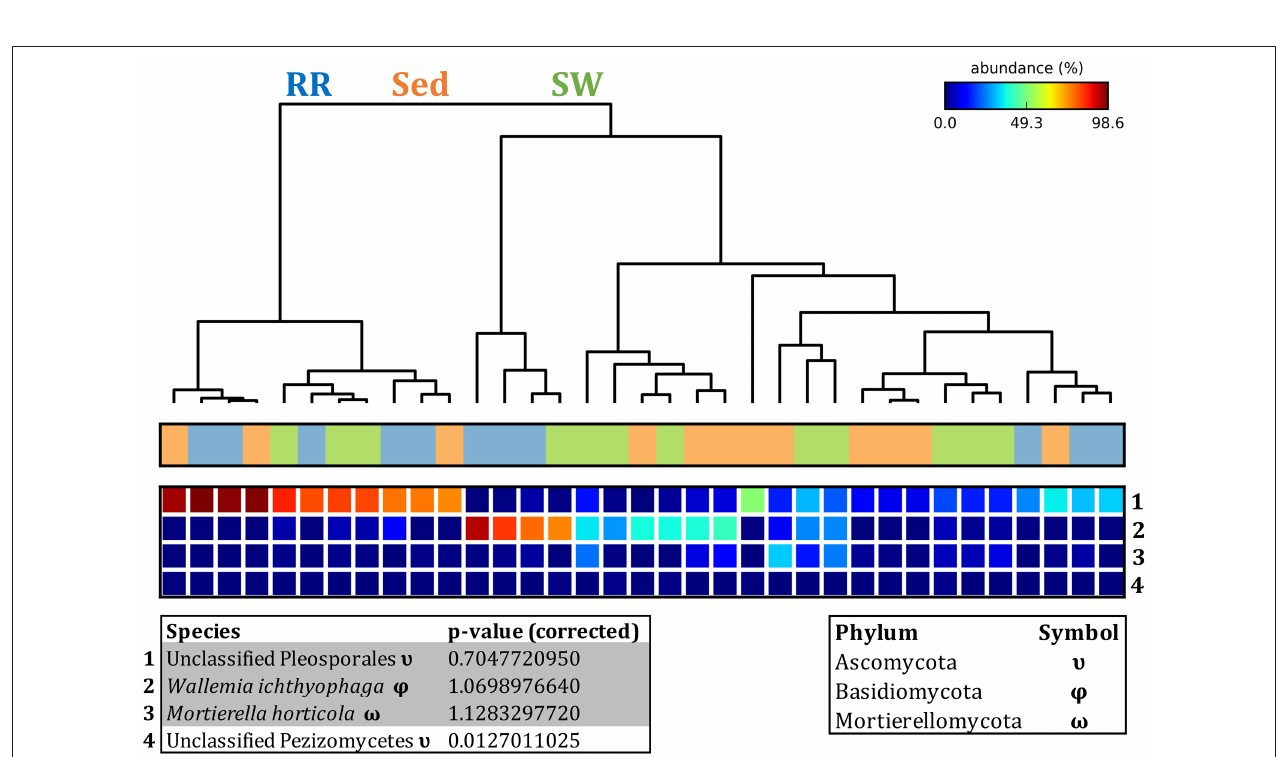
FIGURE 12 | Fungal discriminatory OTUs at the microenvironmental scale. Extensive hypothesis testing of taxonomic profiles was coupled with similarity percentages analyses (SIMPER) for fungal microbiomes across microenvironments. The proportion of sequences (mean frequency %) of OTUs significantly over-represented (Kruskal–Wallis H-test, α = 0.05, effect sizes: η 2 ) and consistently contributing to the differences between microenvironments is indicated by varying color intensities. Corrected p -values were calculated using the Benjamini–Hochberg’s approach. Two-way crossed SIMPER analyses were performed with site and microenvironment variables as factors (S17 Bray–Curtis similarity matrix). High contributors were selected from the top-5 contributors of each pair-wise comparison between microenvironments, and those OTUs consistently accounting for the dissimilarities between any given microenvironment and the other two microenvironments were chosen as high contributors to couple with the statistical results. High contributors that were significantly over-represented were classified as discriminatory OTUs (i.e., 1–4). OTUs are sorted by decreasing mean abundance, and samples are clustered by average neighbor distance (UPGMA, distance threshold = 0.75) and colored by microenvironment. Different symbols represent the distribution of enriched phyla. High contributors that were not significantly over-represented (gray) were also classified as discriminatory OTUs if their contribution to the differences between microenvironments was consistent. RR, roots and rhizomes; Sed, sediment; SW,